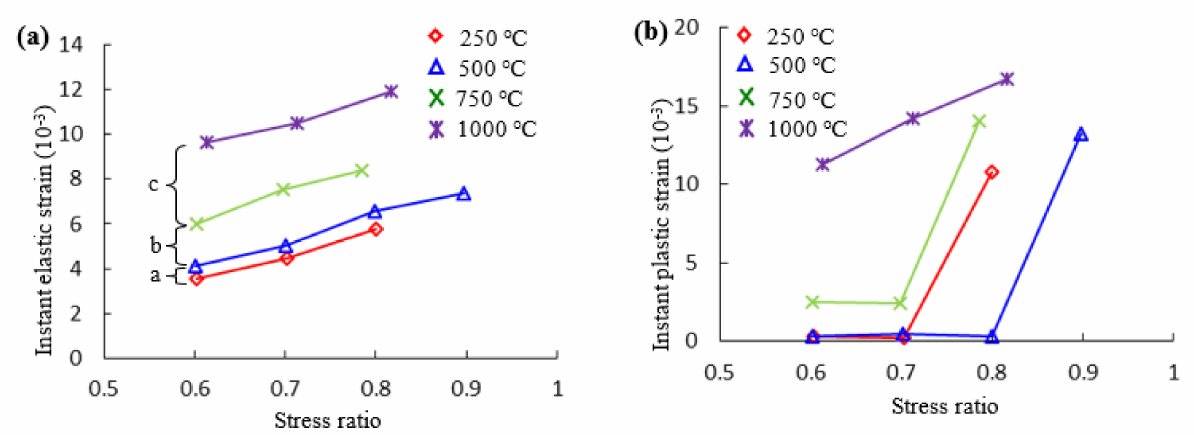
Figure 9. Relationships between stress ratio with instantaneous elastic strain and plastic strain after different temperature treatment. ( a ) Relationship between stress ratio and instantaneous elastic strain; ( b ) Relationship between stress ratio and instantaneous plastic strain.